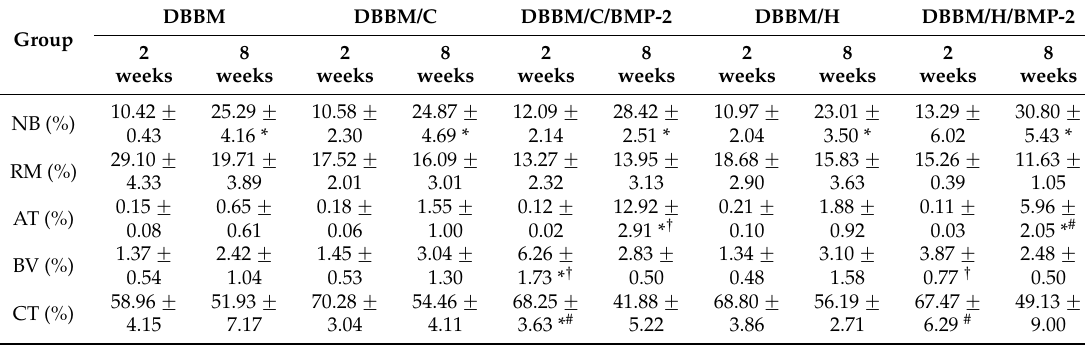
Table 1. Histomorphometric results in sinus-augmentation model: proportion of composition in the total augmented area (mean ˘ SD